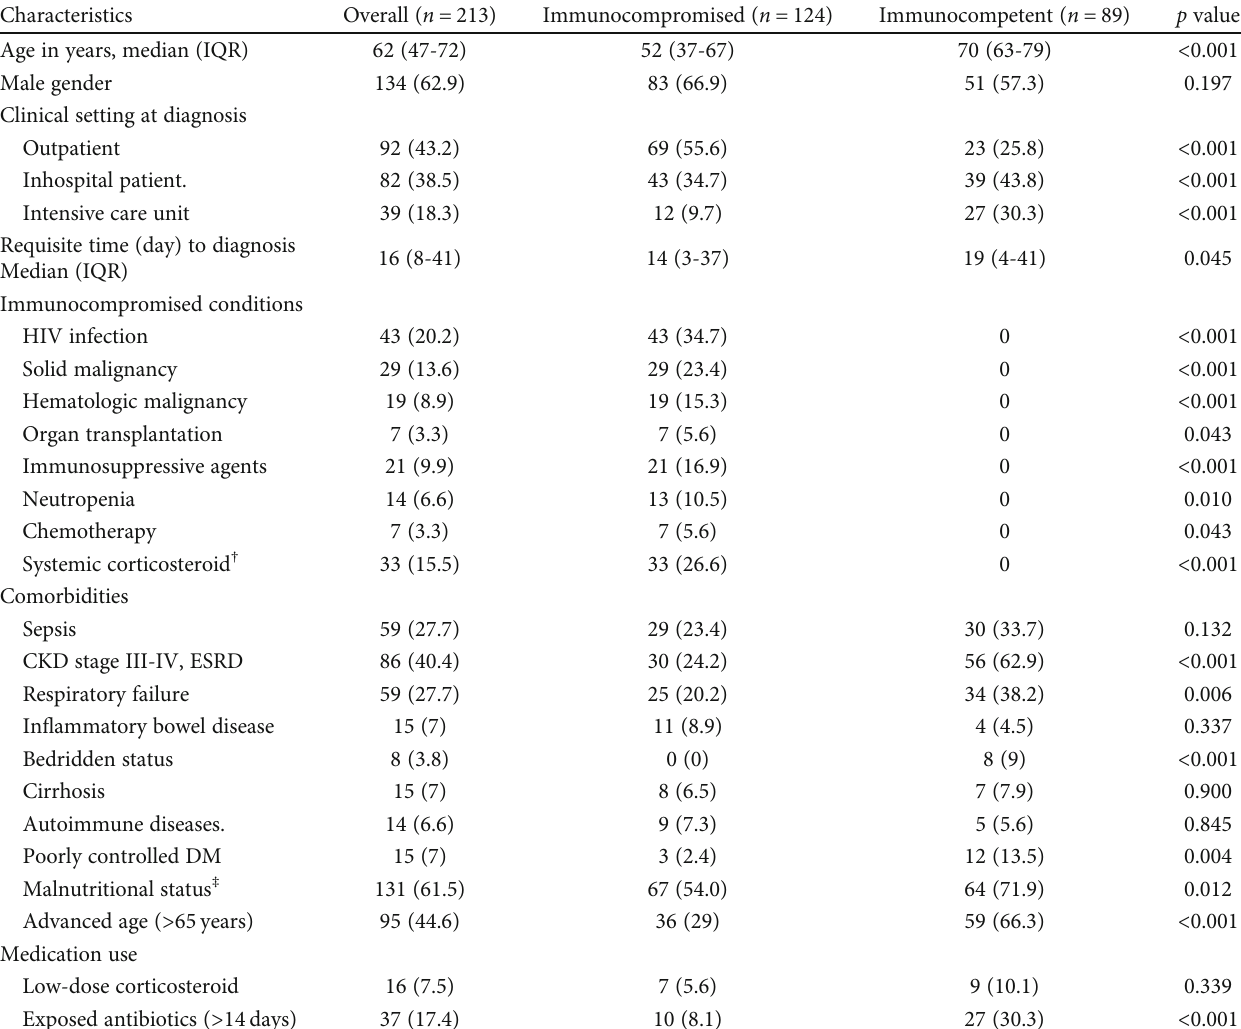
Table 1: Baseline characteristics of TI-GI CMV disease between immunocompromised and immunocompetent patients.